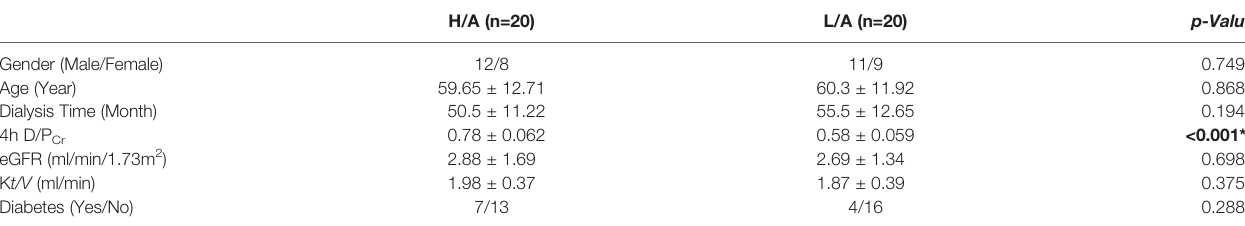
TABLE 3 | Demographic and clinical characteristics of subjects in validation